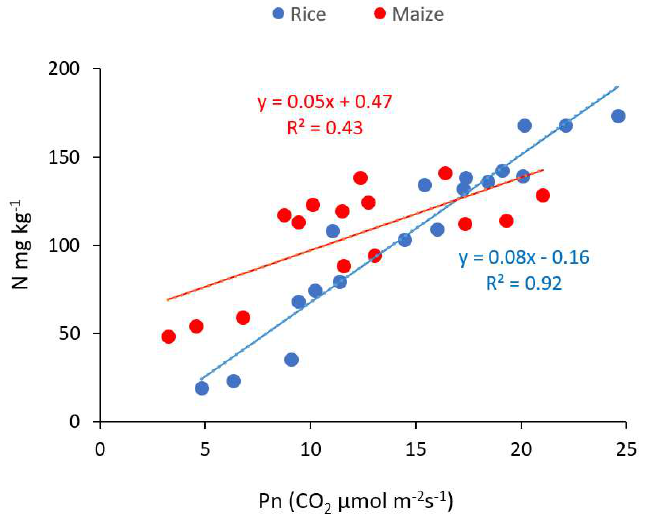
Figure 3. Effects of biochar and cadmium treatments on photosynthesis rate (Pn) in rice and maize field as representatives of C3 and C4 plants, respectively (means ± standard error). Significant differences of means are shown by different capital letters for rice and lowercase letters for maize ( p < 0.01).